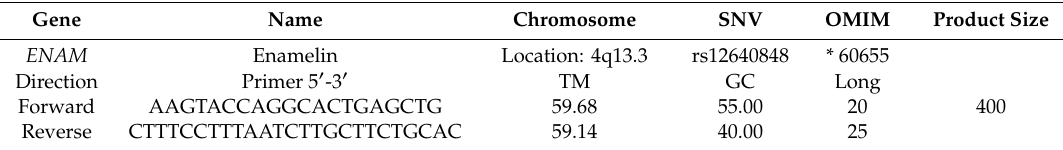
Table 1. Primers designed for ENAM variant rs12640848